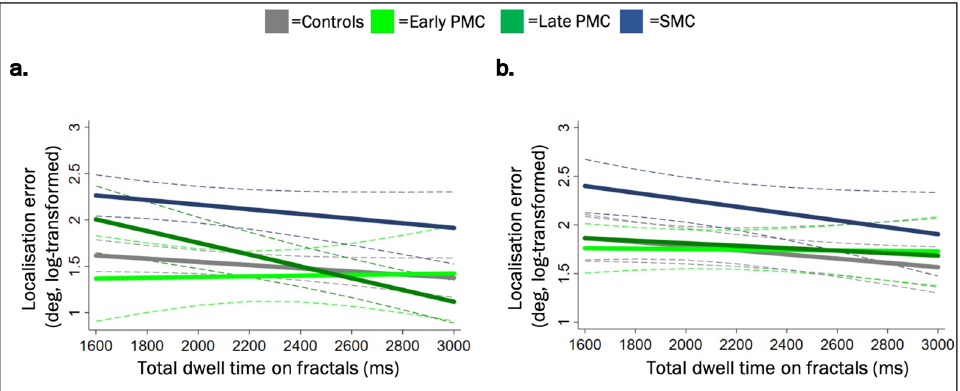
Figure 4. ( a ) 1-s delay: localisation error by the total dwell time on fractals (DT). ( b ) 4-s delay: localisation error by the total dwell time on fractals (DT). Lines represent best fit lines of the DT × group interaction from the multivariable regression model for each delay condition with localisation error as the outcome and NART, sex and DT as predictors. The dotted lines represent 95% confidence intervals. PMC presymptomatic mutation carrier, SMC symptomatic mutation